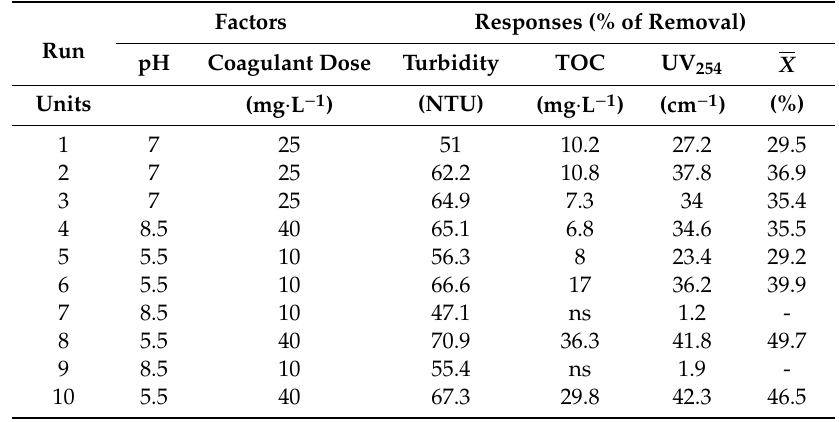
Table 3. Summary of runs, factors, and responses of the model. Raw water characterization: